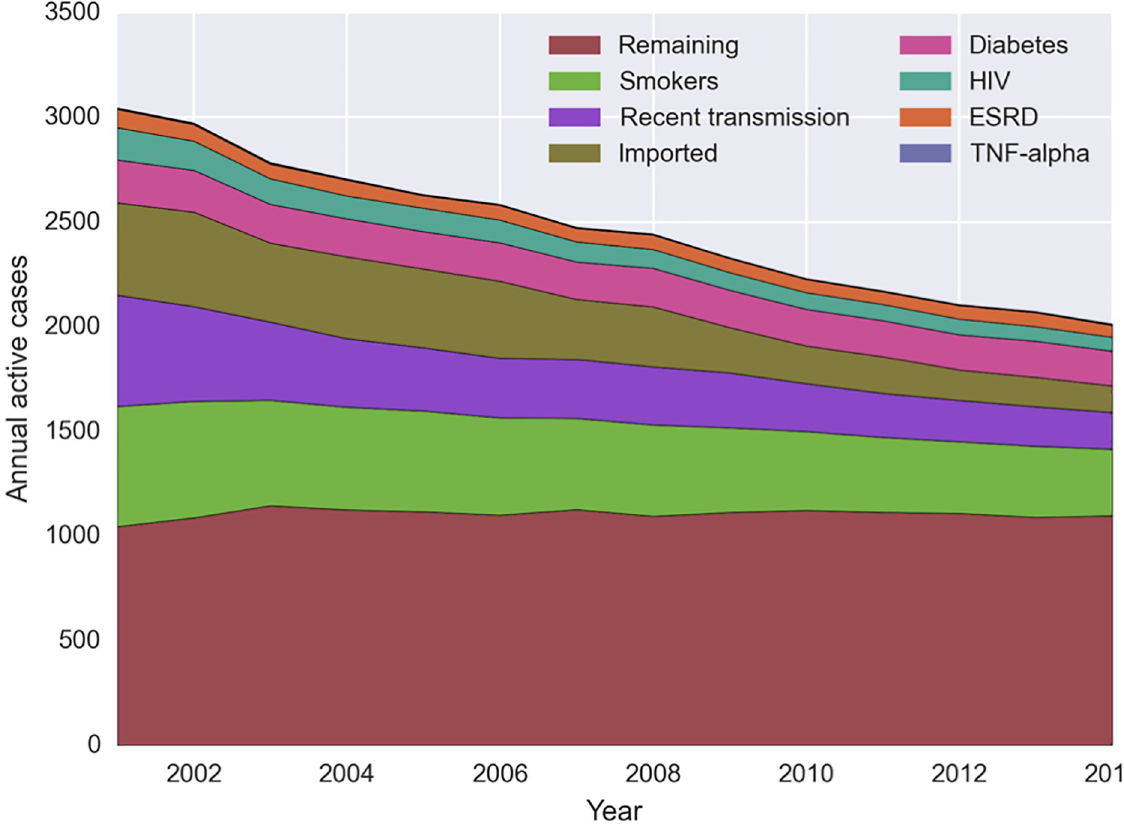
Fig 1. Modelled cases attributable to medical risk factors, recent transmission, and imported cases, 2001–2014. In 2014, the major risk factors for TB were smoking (267 attributable cases), diabetes (162), ESRD (74), HIV (51), transplant (3) and TNF-alpha (1). Increased risk due to recent transmission accounted to 146 cases, and 80 cases were imported. The remaining 1096 cases had no identified risk